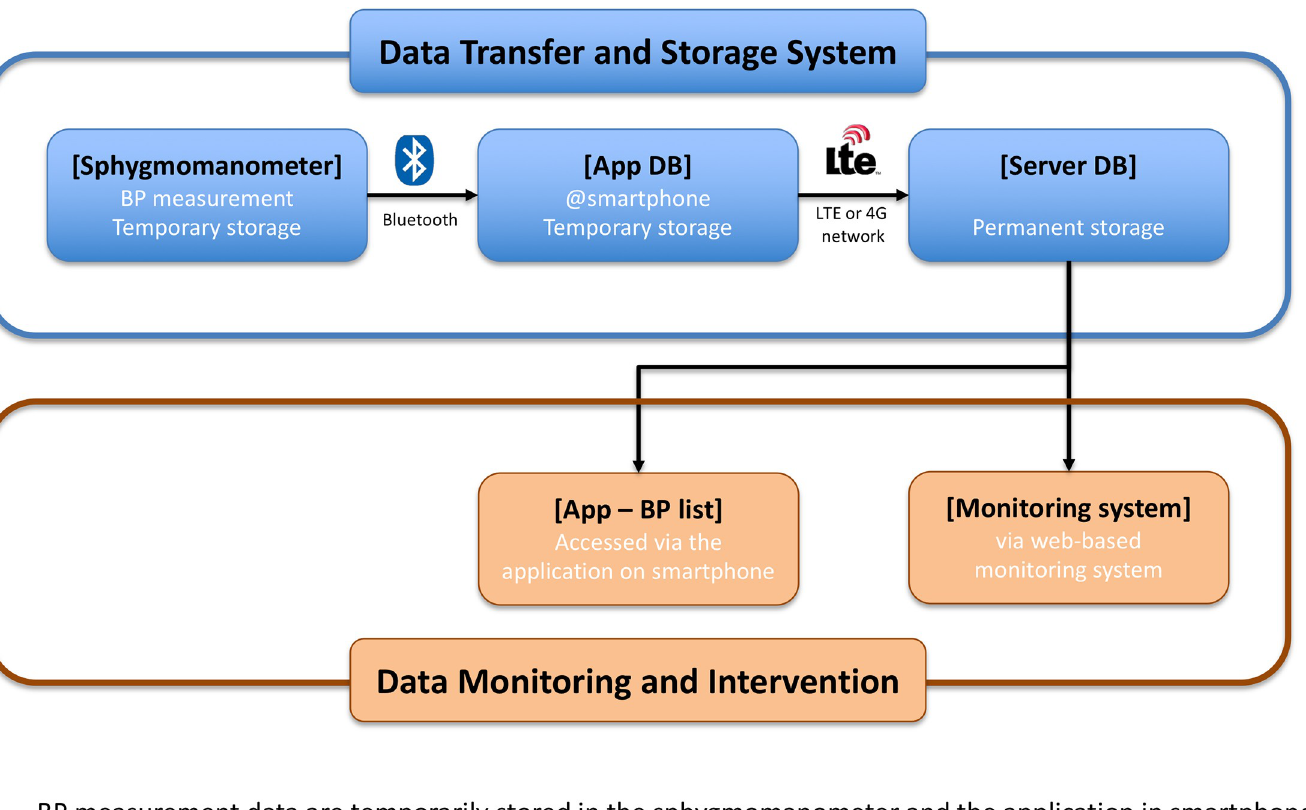
Fig 3. Remote BP measurement, data transmission, storage, and centralized BP monitoring